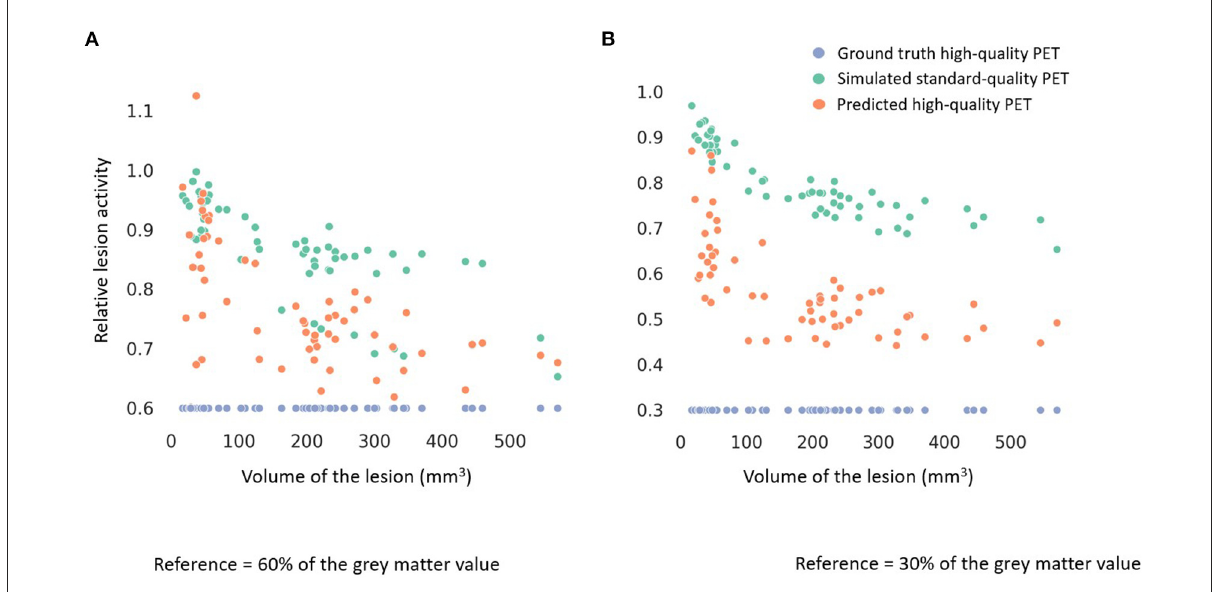
FIGURE5 Scatter plots of the relative lesion activity in the ground truth high-quality (HQ) PET (blue dot), the simulated standard-quality (SQ) PET (green dot) and the predicted HQ PET (orange dot) according to the volume of the lesions (mm 3 ). The lesion ground truth activity in (A) was 60% of the gray matter normal activity and in (B) was 30% of the gray matter normal activity.